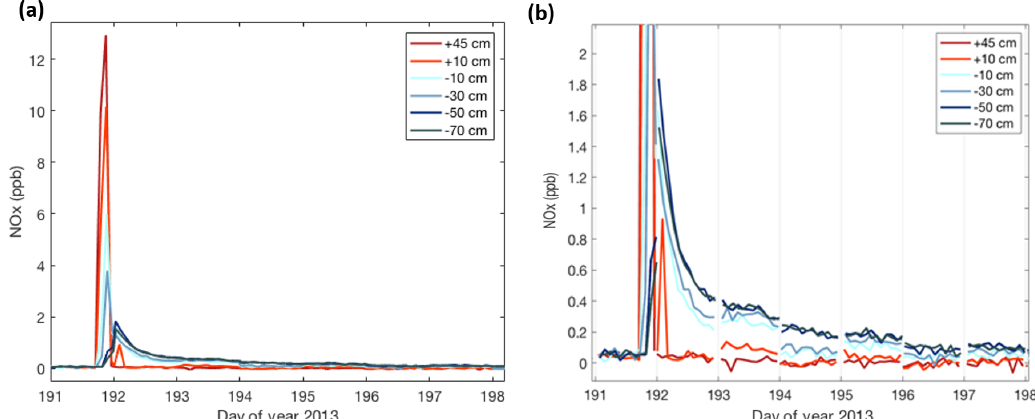
Figure 6. Combined measurements from the two snow towers capturing a pollution event at Concordia during the middle of the winter (day of year 191 = 11 July). Plotted time series traces correspond to the sampling heights indicated in the legend, with positive numbers giving the height above the snow surface and negative numbers the depth below the snow surface. Panel (b) is an enlargement of the data shown in panel (a) with the transitions between the connecting lines between two snow tower measurements removed to show the level of agreement in the data from the two sampling manifolds. The sampling switched between the two snow towers every 24h, leading to some abrupt shifts in the snowpack NO x